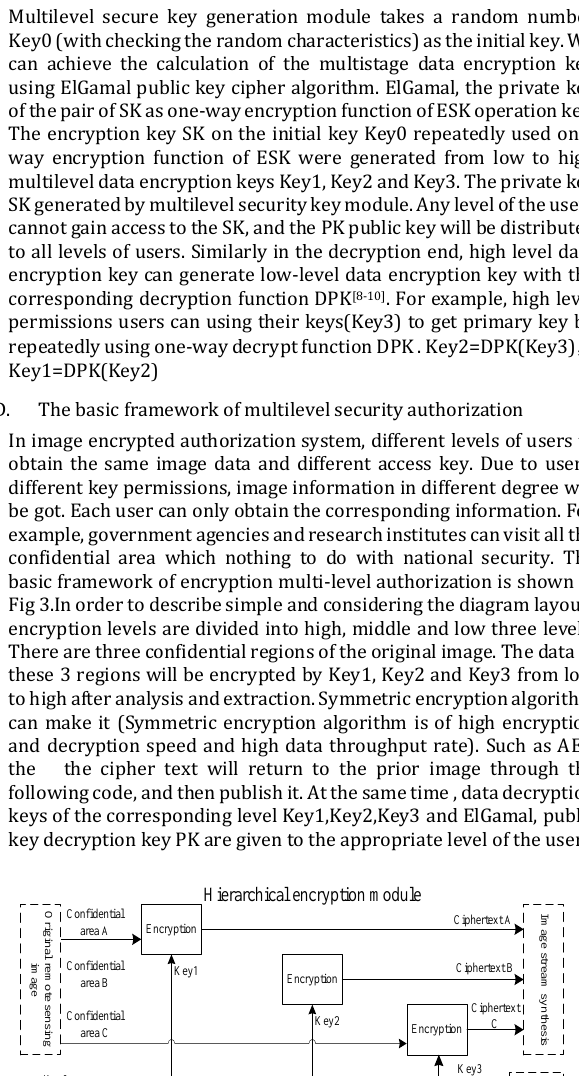
image data is simplified because all the users will get the same data.